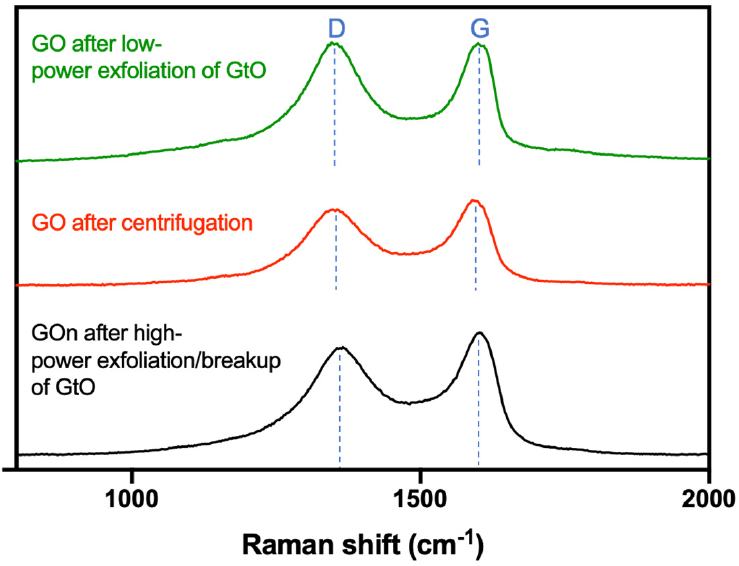
Figure 10. Raman spectra of GO after low-power exfoliation, GO after centrifugation, and GOn after high-power exfoliation/breakup of GtO. Table 3. Position of the band (cm − 1 ) from Raman to GO after low-power exfoliation, GO after cen- trifugation and GOn after high-power exfoliation/breakup pf GtO and respective I D /I G band ratios. Samples